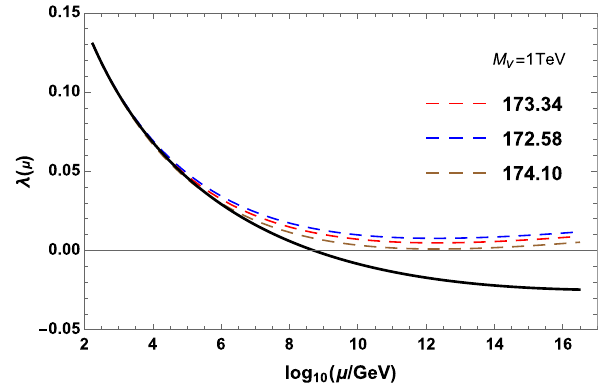
Fig. 4 The two-loop RGE evaluation for the Higgs quartic couplings. The dashed lines stand for the Higgs quartic couplings in our model with the central value and one sigma deviations of top quark mass. The black solid line corresponds to the SM case with m t = 173 . 34